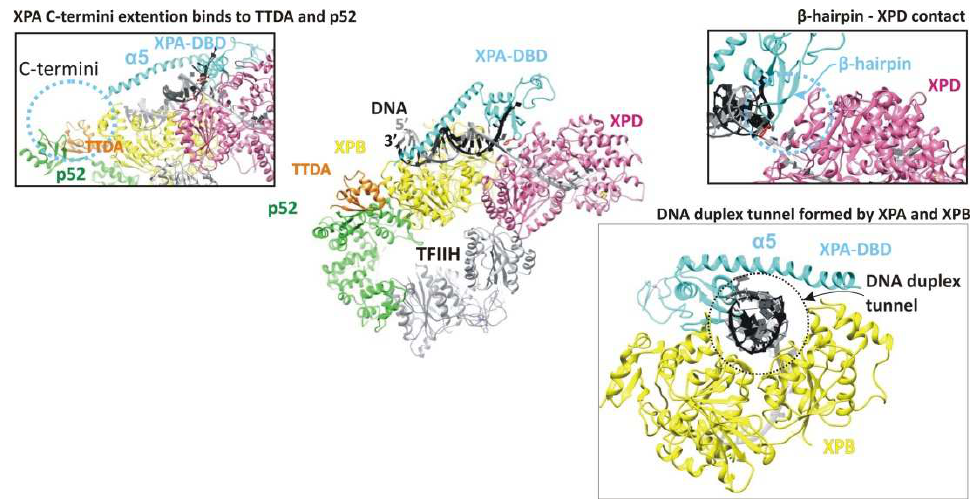
Figure 4. Cryo-EM structure of the human core TFIIH–XPA–DNA complex (PDB ID: 6RO4). XPA is colored light blue. The TFIIH subunits that are directly involved in the interaction with XPA: XPB, XPD, p52, and TTDA/p8 are colored yellow, magenta, green, and orange, respectively. In this complex, XPA forms a bridge between XPB and XPD, and XPA’s extended α5 helix and XPB form a positively charged tunnel that holds the DNA duplex within. XPA binds to XPD via its intercalating β-hairpin. The C-terminal region of XPA should be extended to p52 and TTDA/p8 and bind to these subunits, but unfortunately, it was observed at a lower resolution and was not used for the final model building (for details, please, see original research article [21]). The structures were generated using UCSF Chimera software (version 1.16).